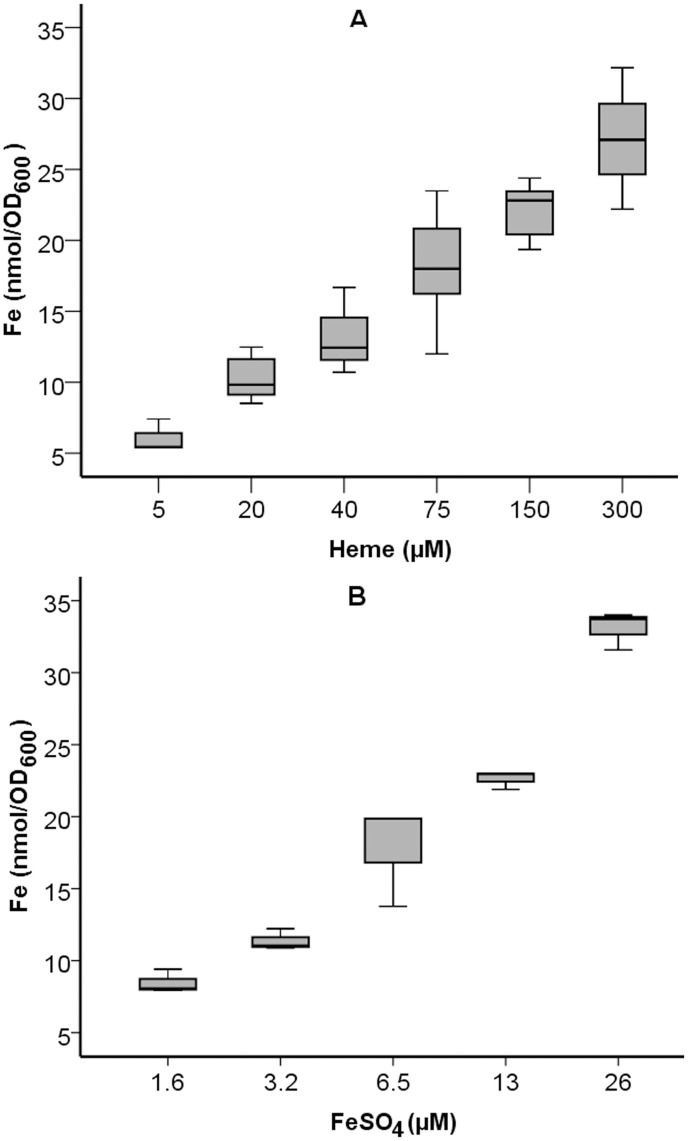
Iron incorporated by iron-depleted SCHU S4 during growth in C-CDM supplemented with increasing concentrations of A) heme or B) FeSO4.Samples for the ferrozine assay were withdrawn between 24 h and 48 h of incubation.